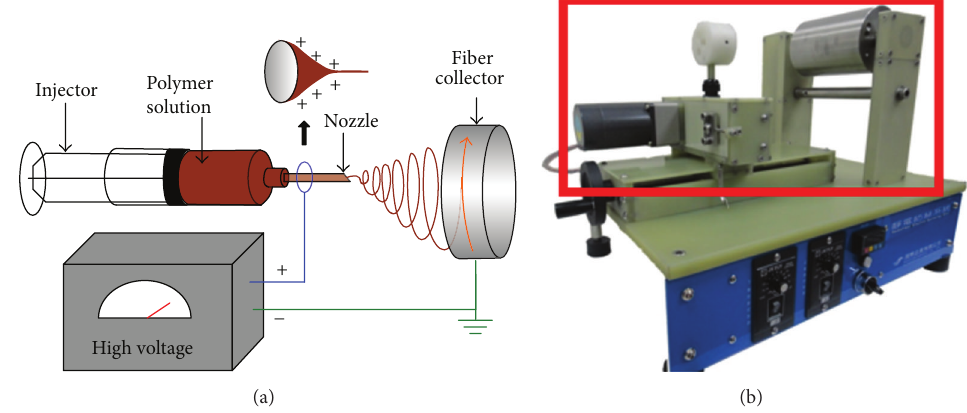
Figure 5: (a) Schematic diagram of electrospinning apparatus and (b) electrospinning machine.